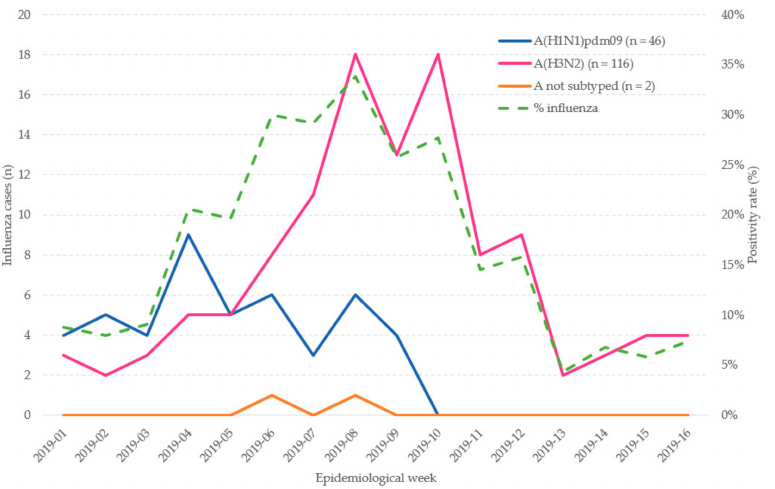
Figure 2. Admissions with laboratory-confirmed influenza by epidemiological week in patients ≥ 65 years old. Influenza positivity percentage by epidemiological week. Valencia Hospital Network for the Study of Influenza (VAHNSI), Spain, in the 2018/2019 influenza